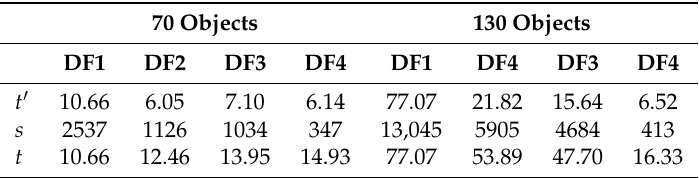
Table 4. The impact increasing the number of layers has on the number of states and the planning time, when there are 70 and 130 objects in the original aggregated PDDL problem file. t is the total planning time in seconds, t (cid:48) the planning time before 1st primitive action was executed and s is number of generated